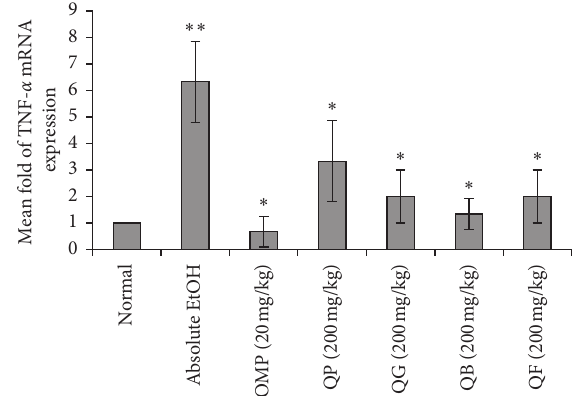
Figure 8: Effect of the four types of processed quinoa seeds on the expression of TNF- α gene in the stomach tissues of experimental rats. Fold change of TNF- α gene expression normalized to GAPDH